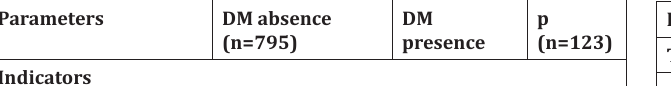
Comparative characteristics of demographic and clinical-laboratory parameters of COVID-19 patients with and without diabetes